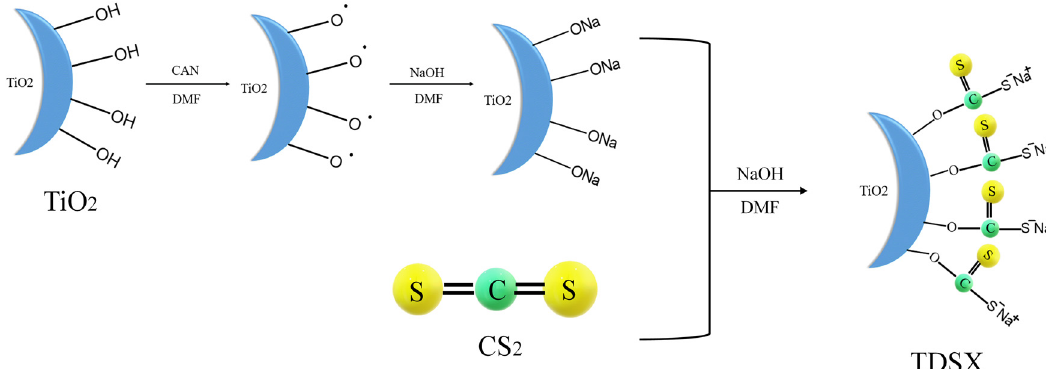
Figure 1: The synthetic route of TDSX.